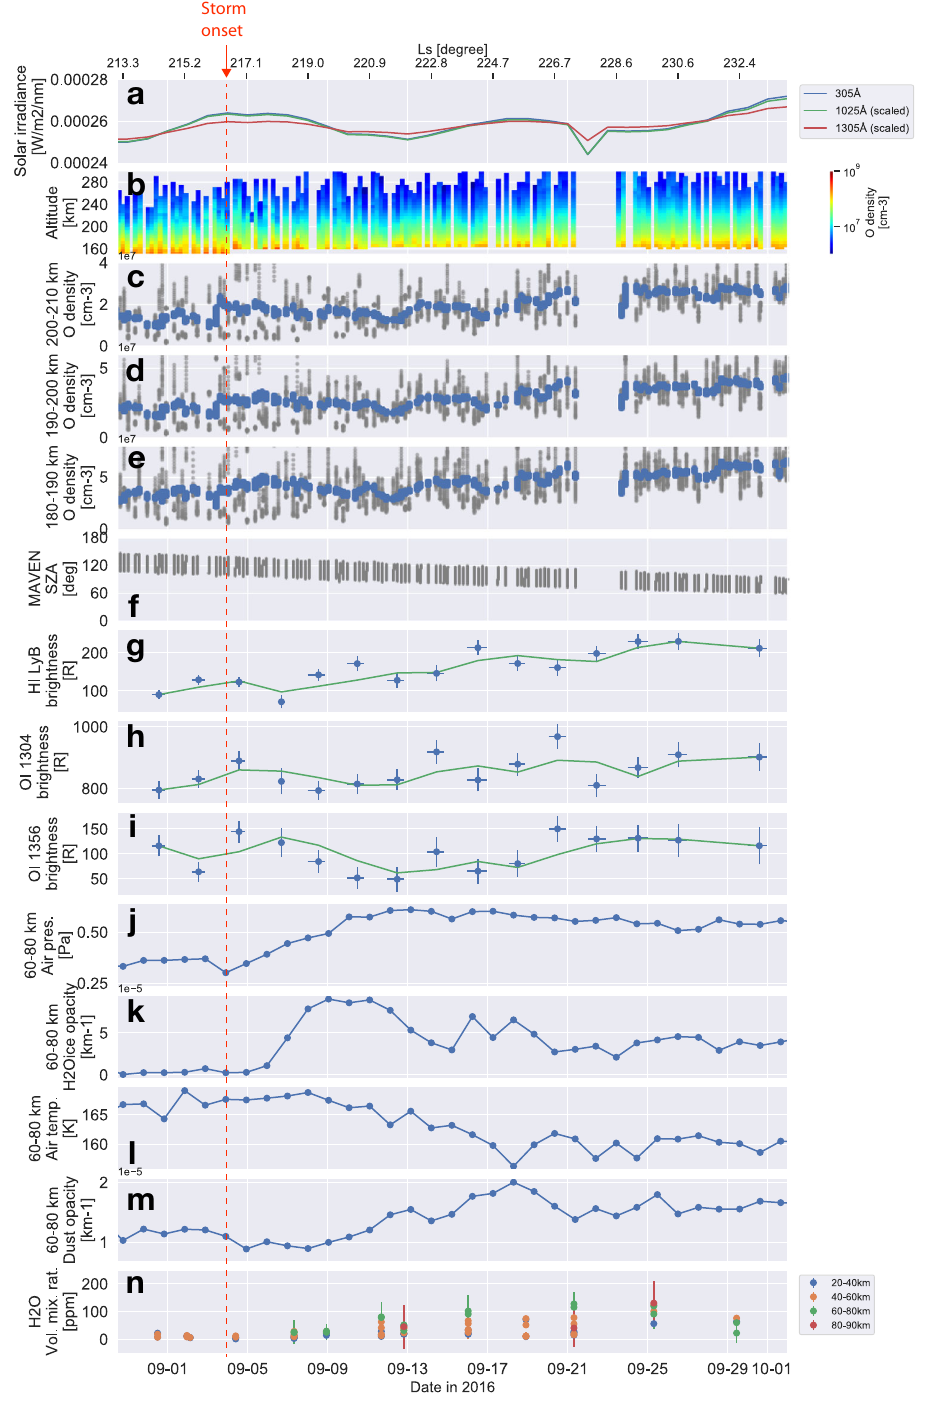
Fig.2|EvolutionofupperatmosphereduringregionalduststorminMarsYear 33. a Time series of the solar ultraviolet fl uxes of Mars Atmosphere and Volatile EvolutionExtreme UltravioletMonitor l3data, b mean O number density pro fi le at 150 – 300km, and ( c – e ) O number density at 200 – 210km, 190 – 200km, and 180 – 190km (grey dots for original data and blue dots for 1-day running mean), f solarzenithangleofMAVENposition, g – i diskbrightnessofhydrogenandoxygen airglow, as observed by the Hisaki telescope (the error bars denote 1 σ standard deviation), j airpressure, k H 2 Oiceopacity, l airtemperature,and m dustopacityat